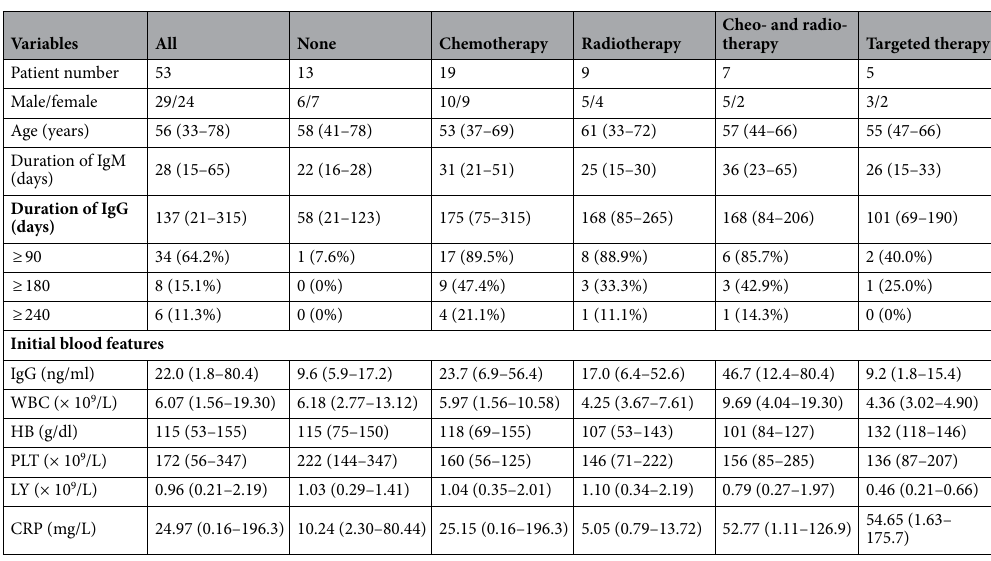
Table 1. Clinical characteristics of the cancer patients recovered from COVID-19 under different treatments. Data are numbers, mean (range) or n (%) unless otherwise indicated. WBC white blood cell, HB haemoglobin, PLT platelet, LY lymphocyte, CRP C-reactive protein, none non-chemo or